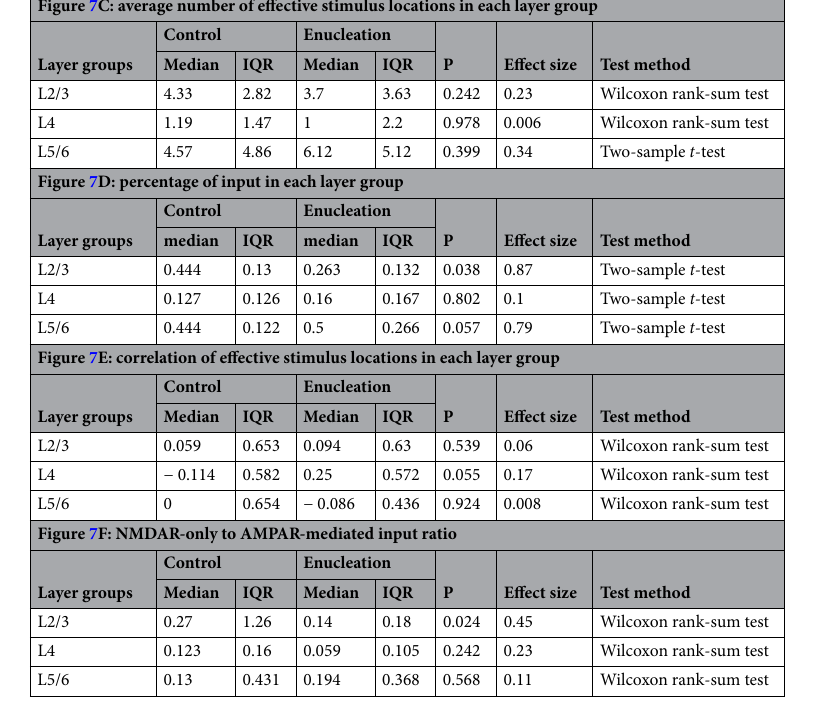
Table 7. Statistics in Fig. 7. IQR interquartile range.